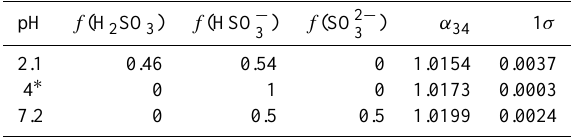
Table 3. Fractionation factors for SO 2 uptake and oxidation at dif- ferent pH values. Values at pH=2.1 and 7.2 were measured at 19 ◦ C during the aqueous oxidation of SO 2 in 1% H 2 O 2 at two differ- ent pHs. The fractionation factors are the average of duplicate ex- periments and the uncertainty is the 1 σ error in the measurements. ∗ pH=4 was measured by Egiazarov et al. (1971) and does not in- clude a terminating oxidation reaction.